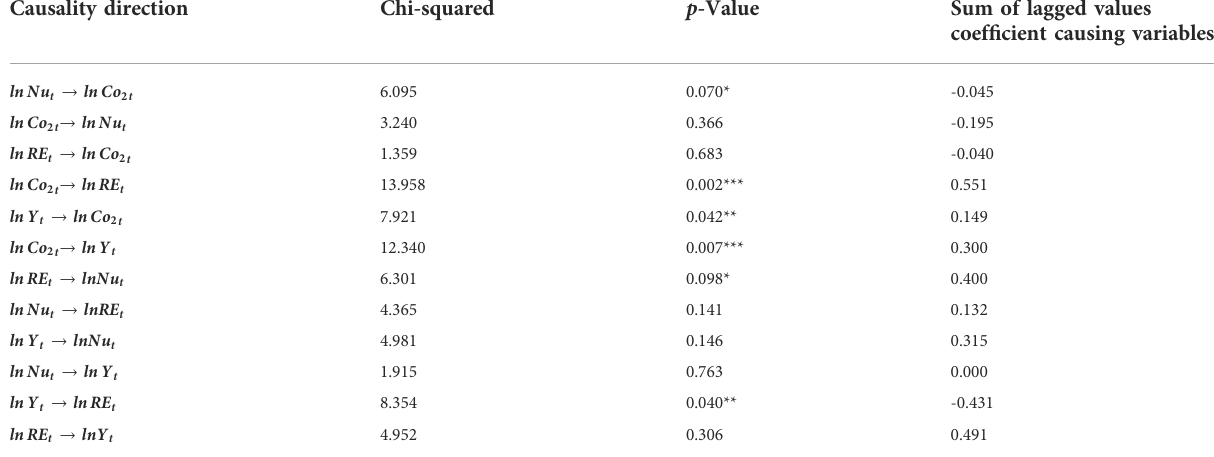
TABLE 2 Granger causality